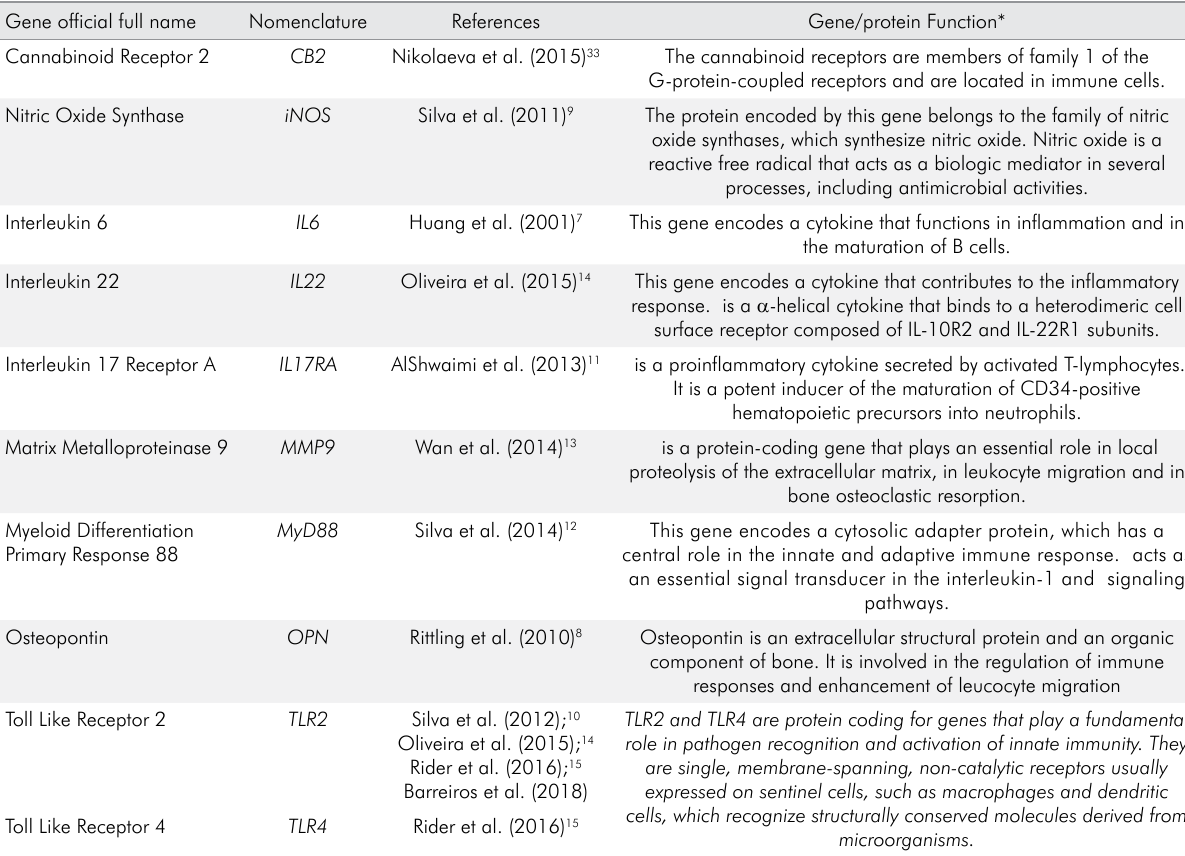
Table 2. List of candidate genes, in alphabetic order, based on the animal knockout (KO) model